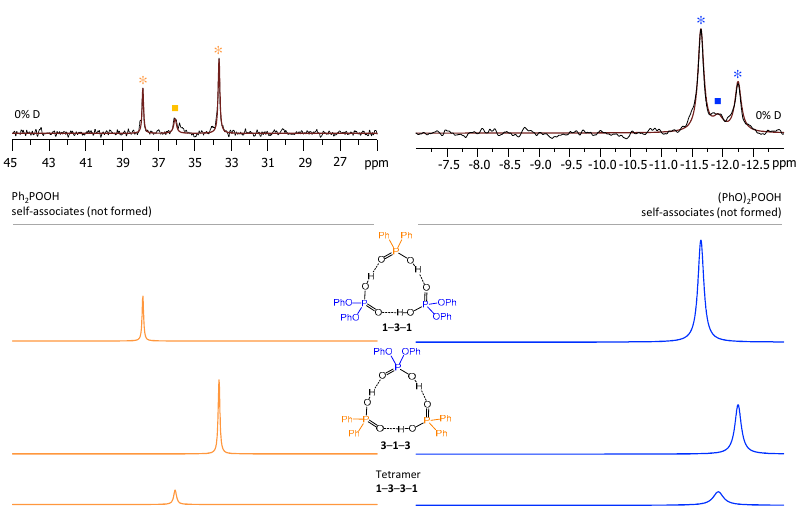
Figure 6. The parts of 31 P NMR spectrum of the sample containing acids 1 and 3 (1.2:1) in CDF 3 /CDF 2 Cl at 100 K. The experimental spectrum is deconvoluted into the sub-spectra arising from self-associated of 1 or 3 , heterodimer 1 - 3 , two heterotrimers, 1 - 3 - 1 and 3 - 1 - 3 , and a tetramer, consisting of two molecules of 1 and two molecules of 3 in a cyclic 1 - 3 - 3 - 1 configuration. For visual clarification the signals in the experimental spectrum and the computed sub-spectra are color coded. Trimers and tetramers are marked by asterisks and squares, respectively.